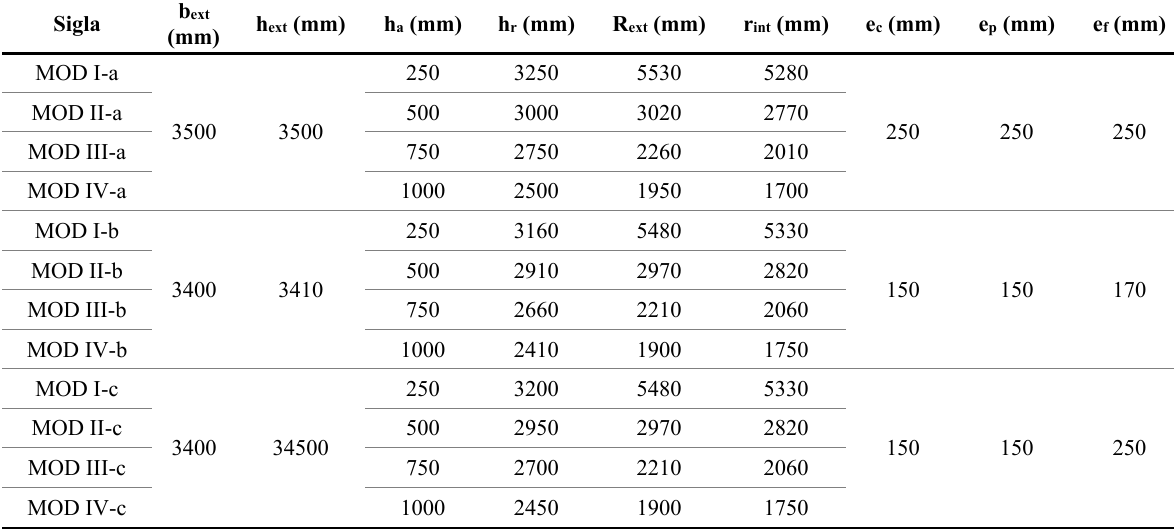
Table 1. Geometric parameters of the modified